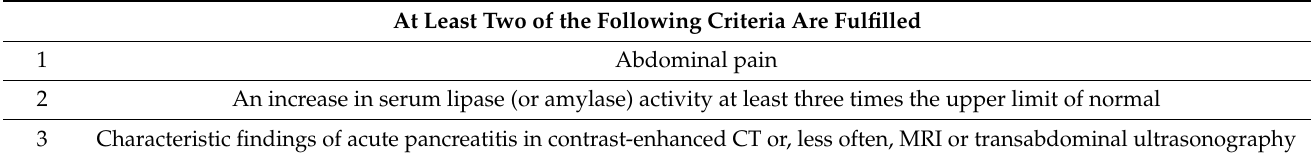
Table 1. AP diagnosis criteria according to the Atlanta classification